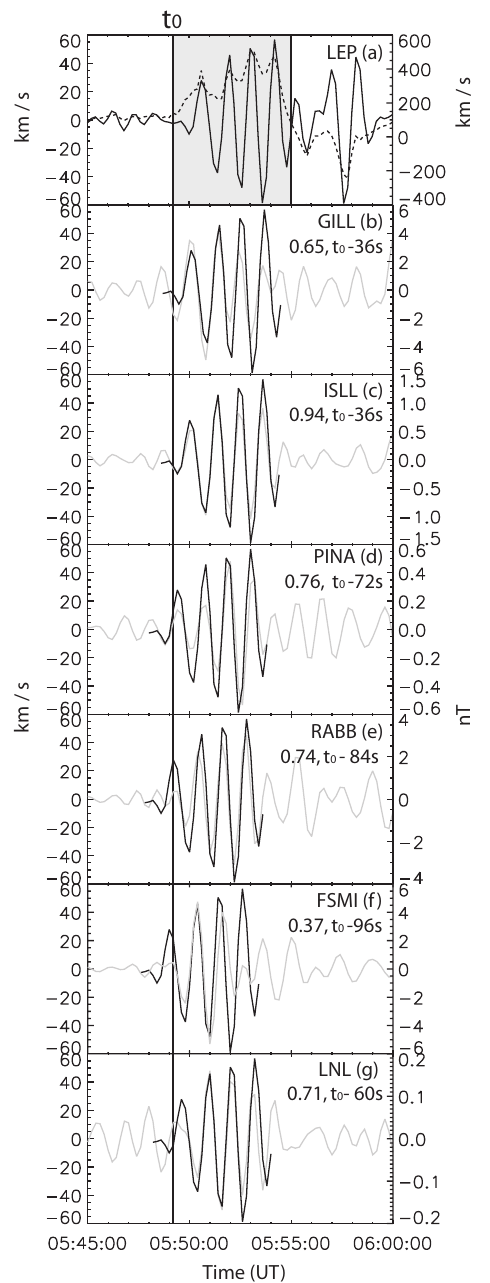
Fig. 6. The top panel, (a) , shows the v ⊥ x plasma flow bandpass filtered between 55–95s, approximately 11 and 17mHz. The high- light depicts the section of the BBF which is used to calculate the BBF-Pi2 correlation coefficient; t 0 labels the beginning of the BBF, at 05:49:12UT. Panels (b) – (g) show the Pi2 observed at each magnetometer station (grey), and over plotted is the BBF (black), this having been time-shifted such that the correlation between the ground magnetic pulsations and FBs is maximized. Displayed in the upper right corner of panels (b) – (g) is the correlation coefficient squared and the amount the BBF is shifted relative to t 0 , cf., Table 2, e.g., 0.65, t 0 − 36s, in the case of the GILL